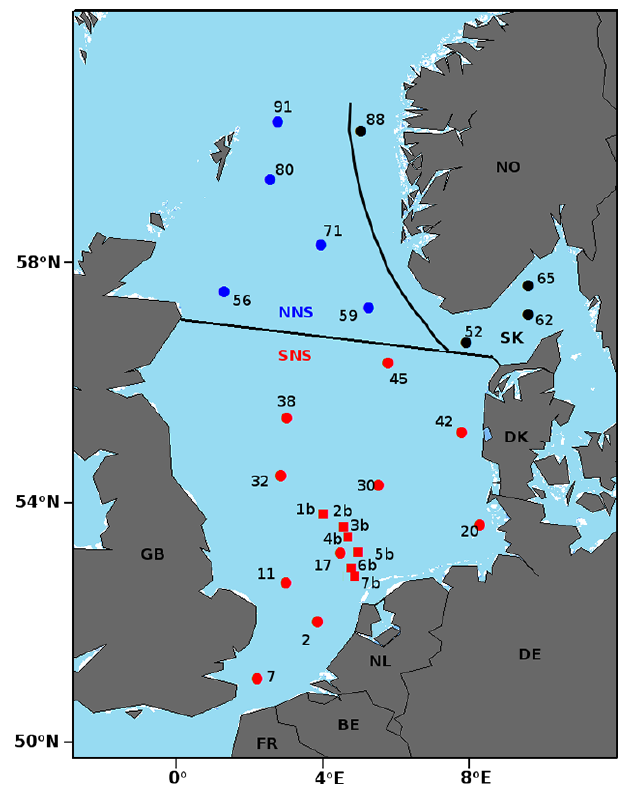
Figure 1. Map of sampled stations. Red symbols: southern North Sea; black symbols: Skagerrak; blue symbols: northern North Sea; circles: sampled in September 2011; squares: sampled in June 2012. Border of the Skagerrak as defined by the International Hydro- graphic Organization; the border between SNS and NNS roughly represents the 100m depth